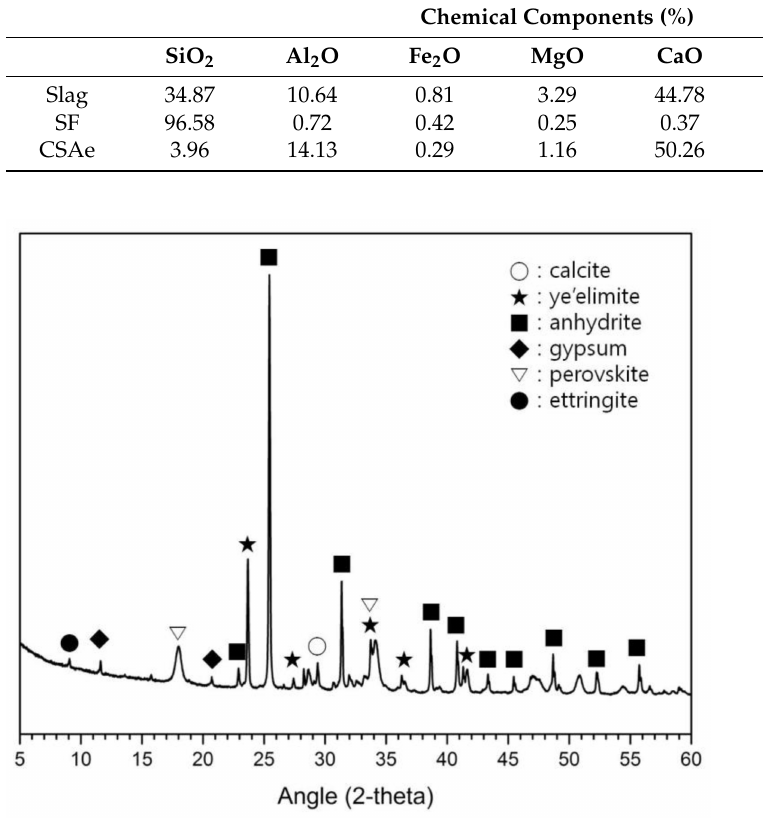
Figure 1. X-ray fluorescence analysis of